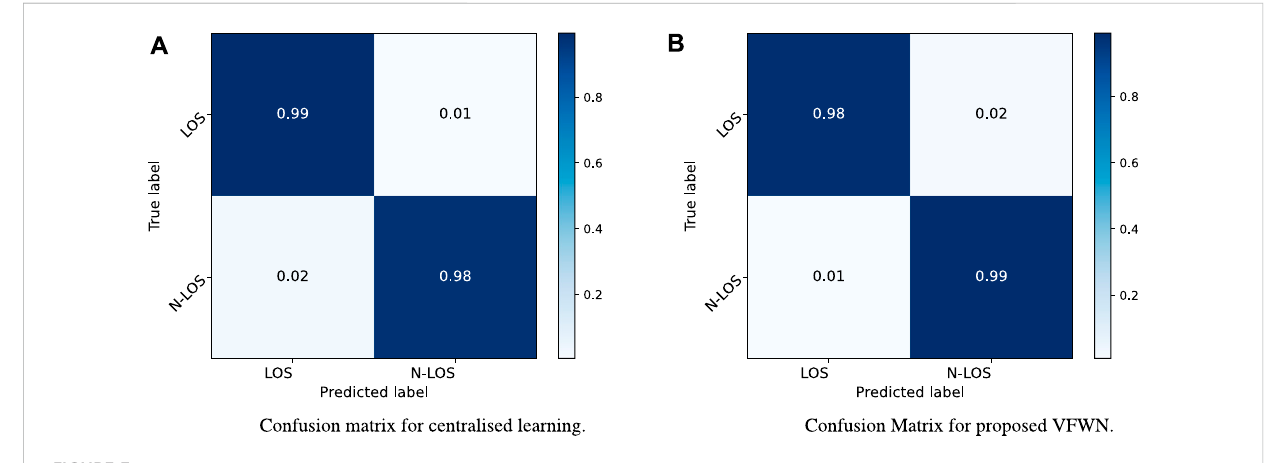
FIGURE 3 The confusion matrices (A) centralised learning, and (B) proposed VFWN.